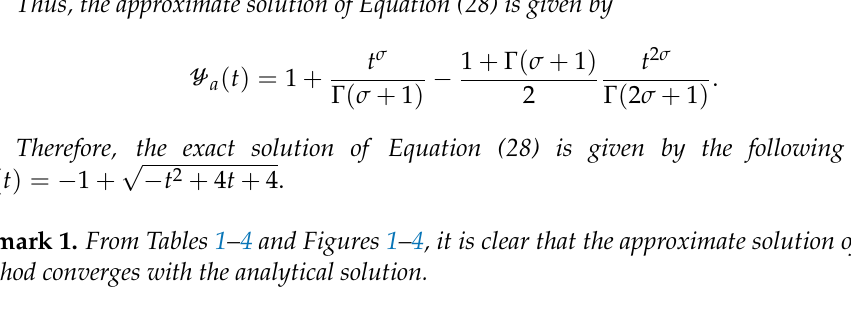
Table 1. Values of the approximate and exact solutions of Equation (19) at di ff erent values of 𝓉 .